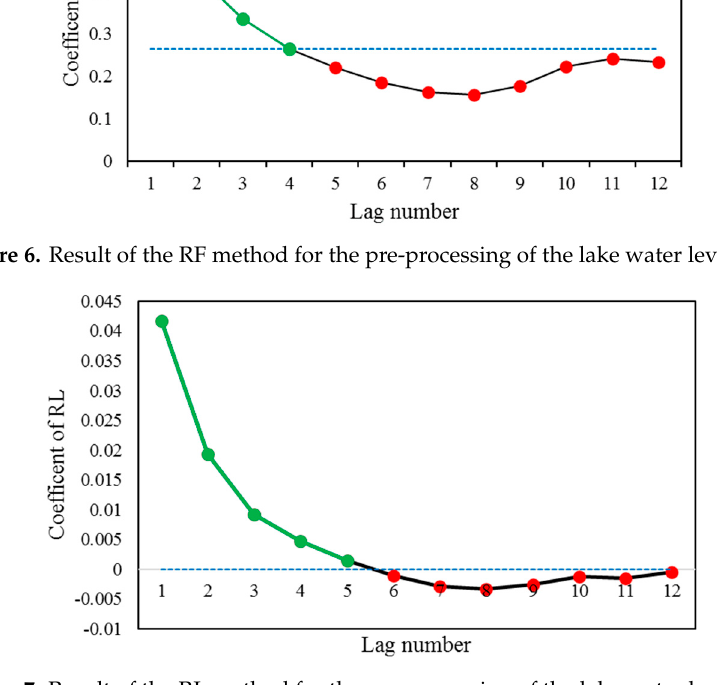
Figure 7. Result of the RL method for the pre-processing of the lake water level data.